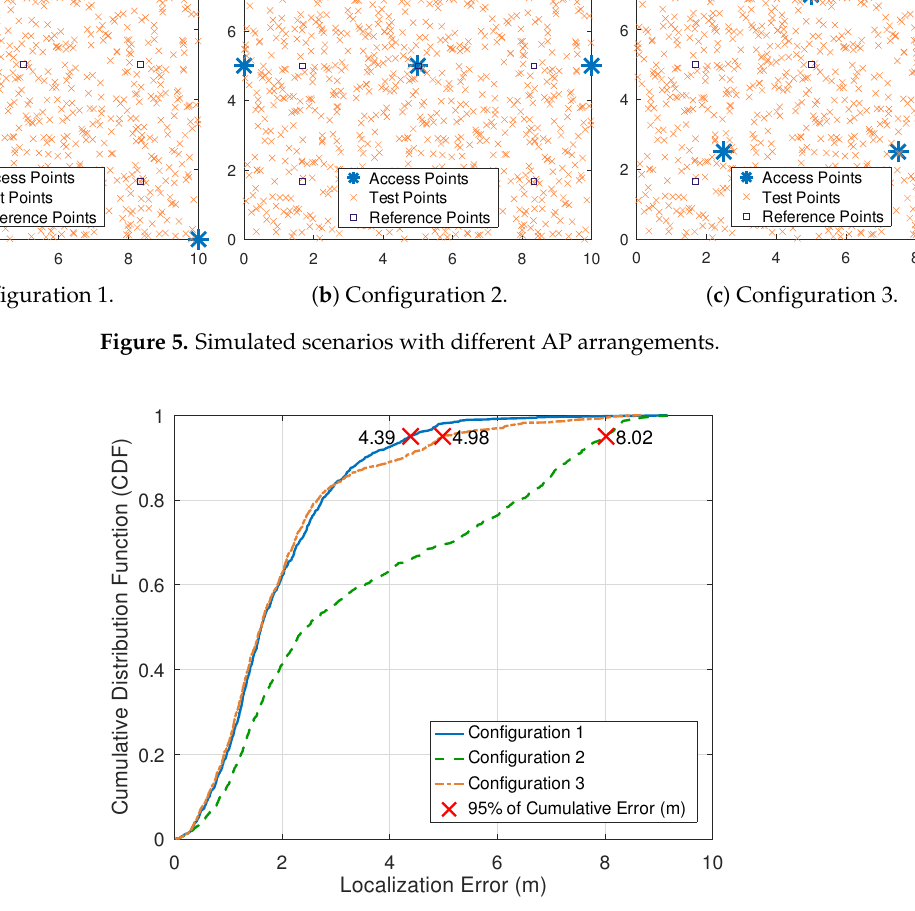
Figure 6. Variation of localization error under the perspective of three different